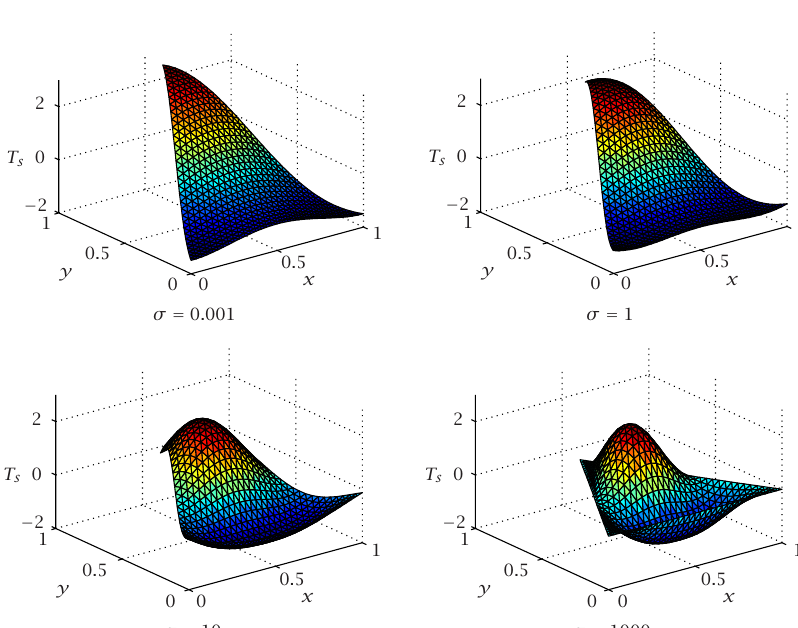
Figure 5.2 . The ( 0 , 1 ) symmetric